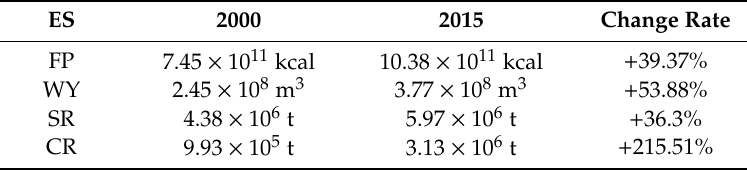
Table A2. The demand amount and changes of four ES from 2000 to